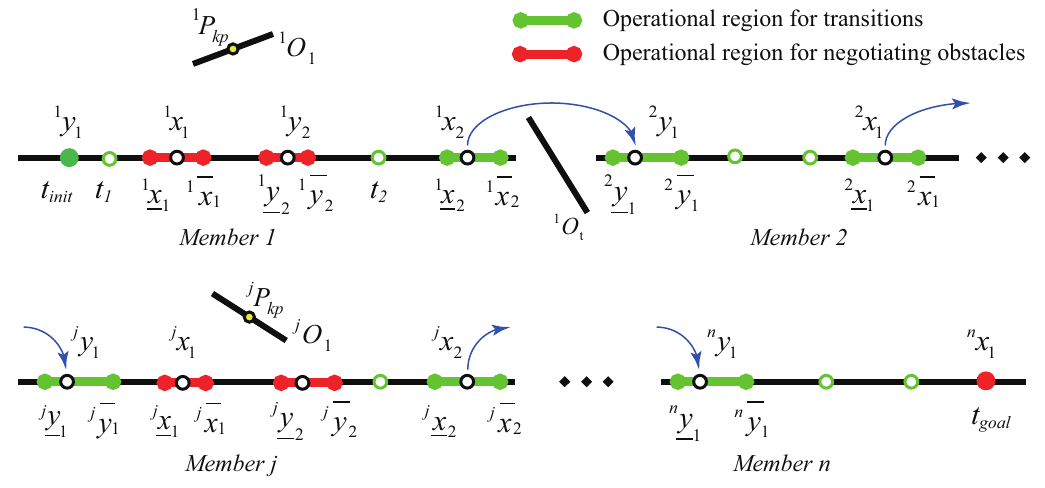
Figure 3. A general model of collision-free grip planning for